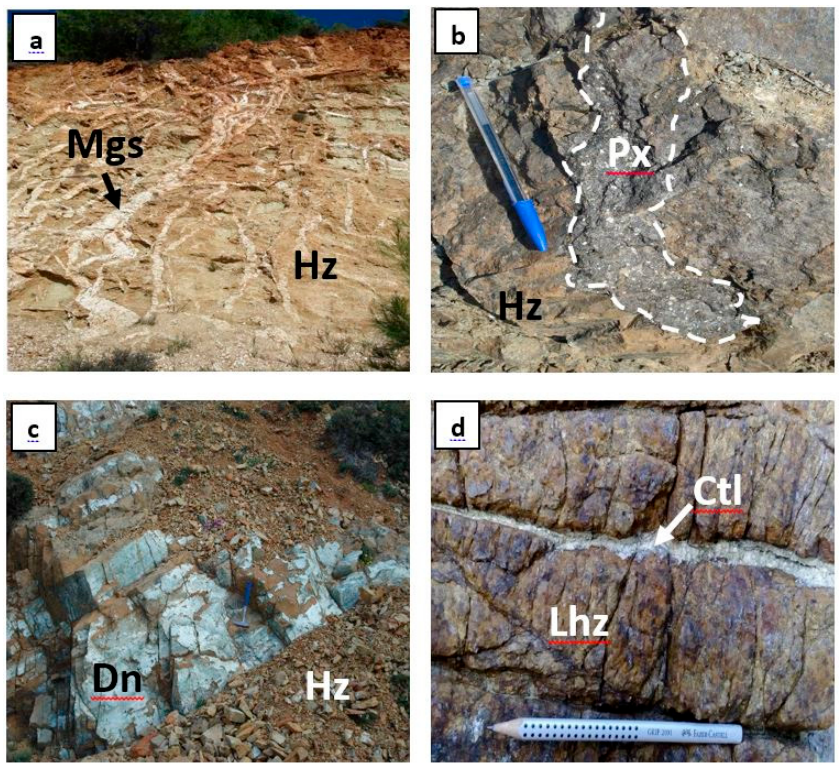
Figure 2. Photographs of the studied ophiolite occurrences: ( a ) Stockwork of magnesite in massive harzburgite (Megaplatanos); the horizontal scale is ~4m; ( b ) Pyroxenite dyke intruding into serpentinised harzburgite (Alyki); ( c ) Dunite layers intercalated with cataclastic harzburgite (Ypato); ( d ) Cross-fibre chrysotile dyke crosscutting coarse-grained lherzolite (Alyki). Abbreviations: Mgs-Magnesite, Hz-Harzburgite, Px-Pyroxenite, Dn-Dunite, Lhz-Lherzolite,